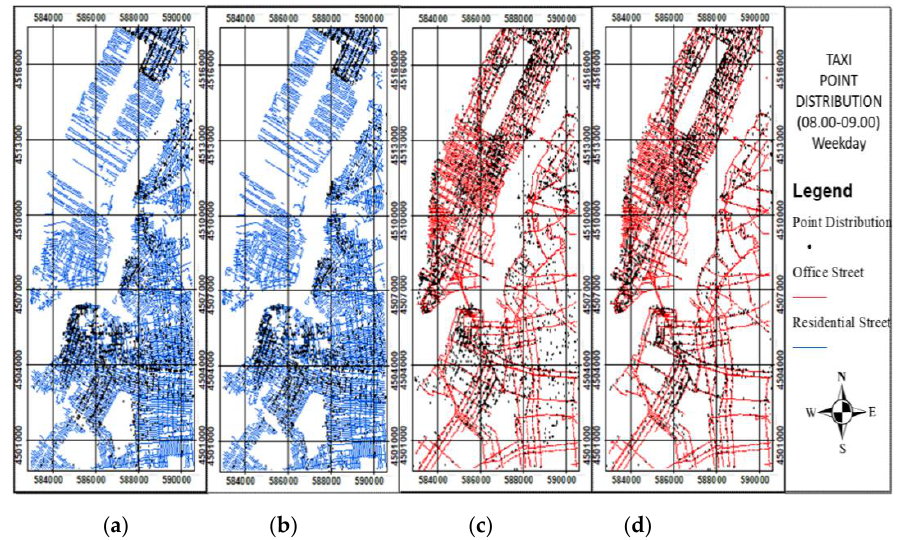
Figure 9. Bike point distribution during the first weekday peak time (08:00 – 09:00): ( a ) origin before data cleaning; ( b ) origin after data cleaning. ( c ) destination before data cleaning; ( d ) destination after data cleaning.